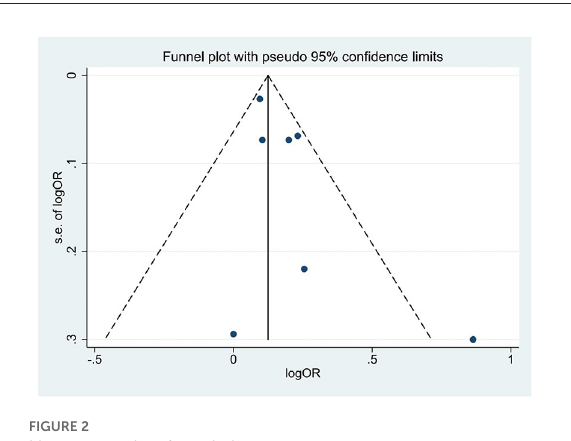
FIGURE2 Literature review funnel